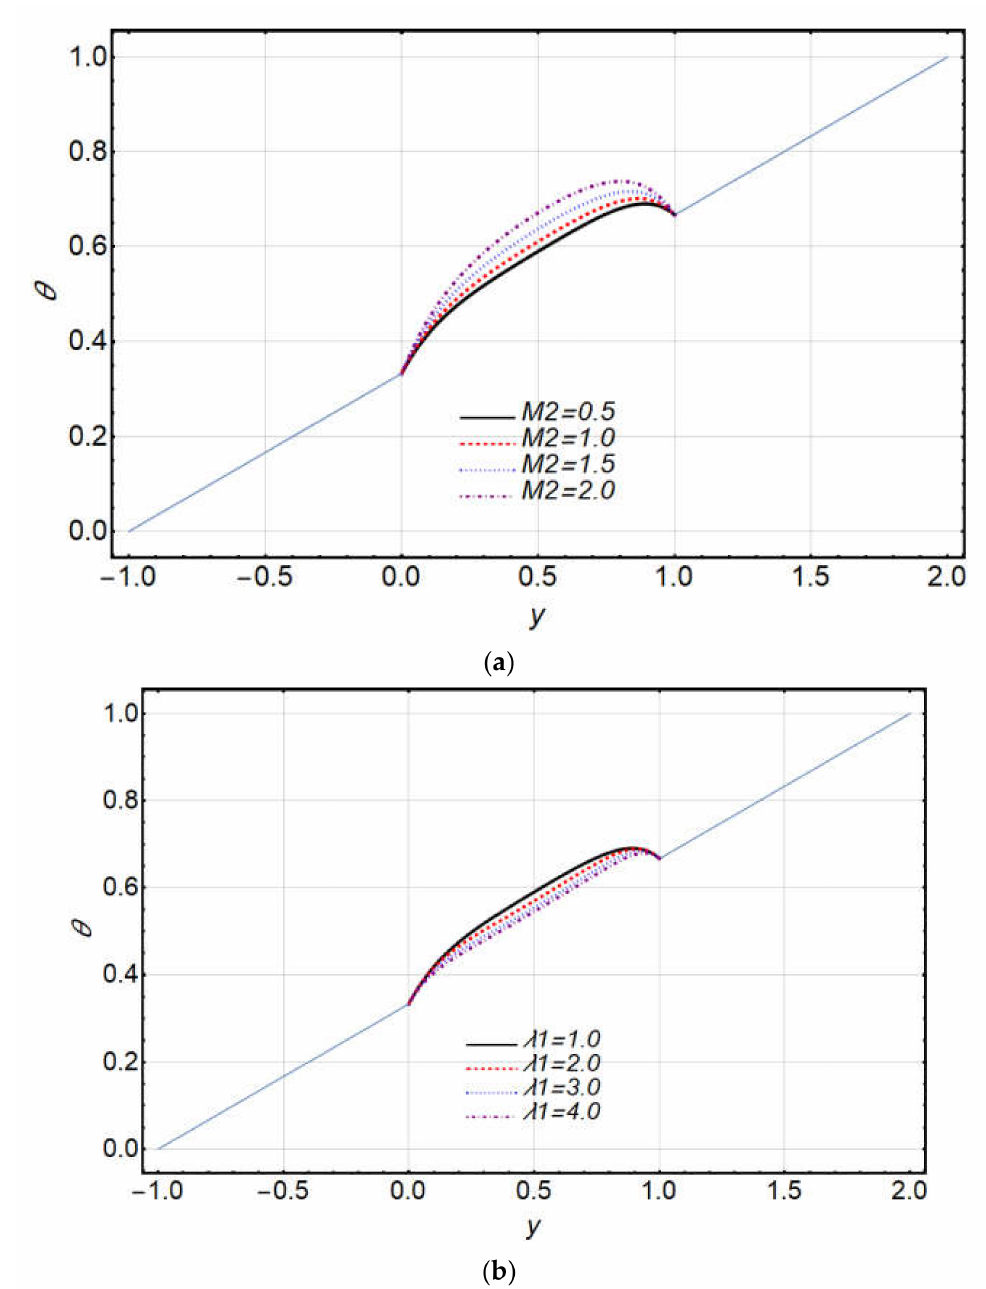
Figure 14. Temperature distribution against ( a ) M 2 , ( b ) λ 1